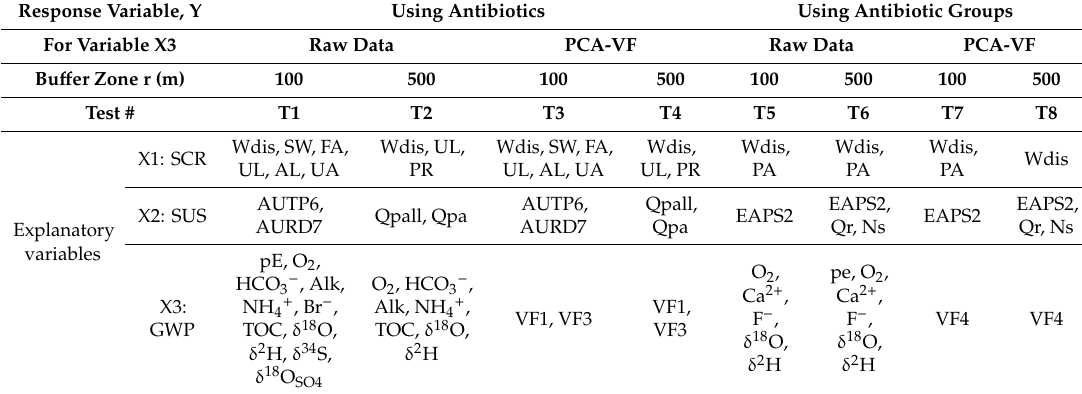
Figure 3. Flow chart of the variable examination and aggregation processes and the distinct combination of variables used for the different tests (T#) conducted in redundancy analysis (RDA)